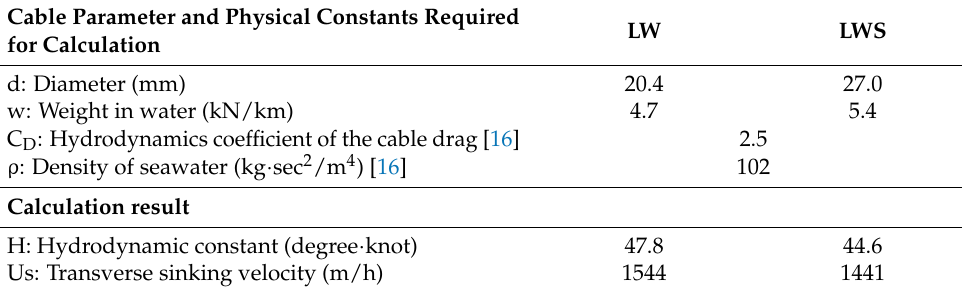
Table 1. Parameters used in calculation and calculated results.